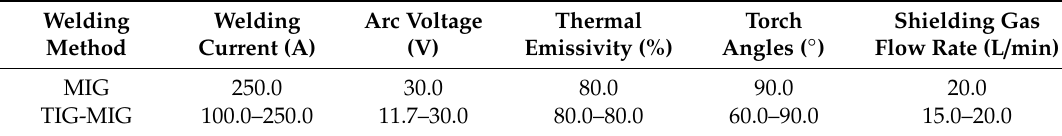
Table 3. Welding parameters used in single-MIG and TIG-MIG